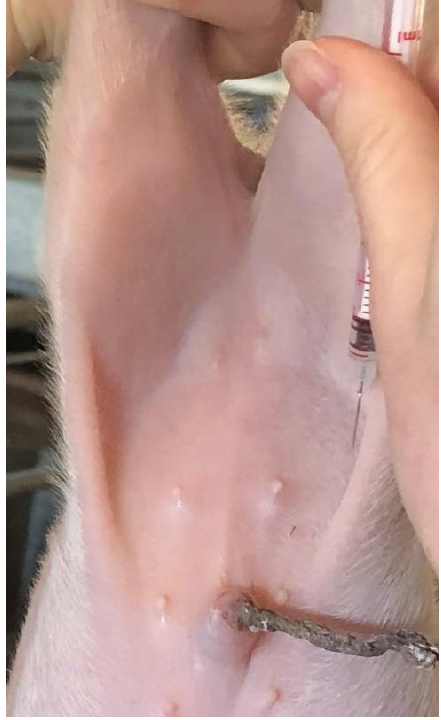
Figure 1. Intraperitoneal injection site of piglets.